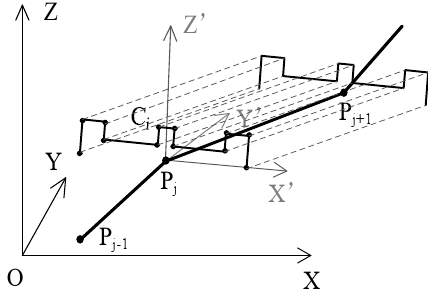
Figure 7. Roadbed mesh construction.